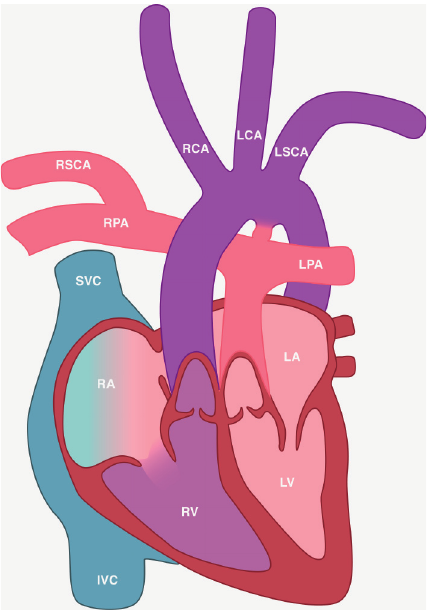
Figure 3: Schematic illustration of a d-transposition of the great arteries (D-TGA) in combination with an aberrant origin of the right subclavian artery (RSCA) from the right pulmonary artery (RPA). IVC, inferior vena cava; LA, left atrium; LCA, left carotid artery; LPA, left pulmonary artery; LSCA, left subclavian artery; LV, left ventricle; RA, right atrium; RCA, right carotid artery; RV, right ventricle; SVC, superior vena